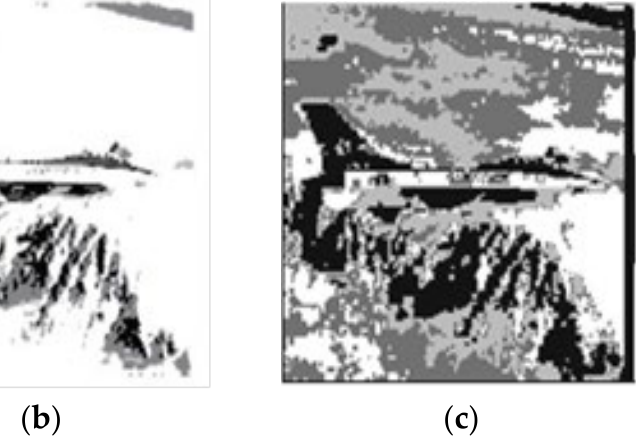
Table 7. Friedman Test based on CE validity index—result for natural